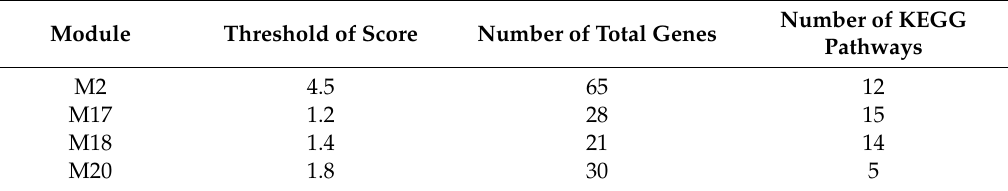
Table 4. KEGG pathway enrichment of conserved first-order genes of modules in the prostate TSPPI network.